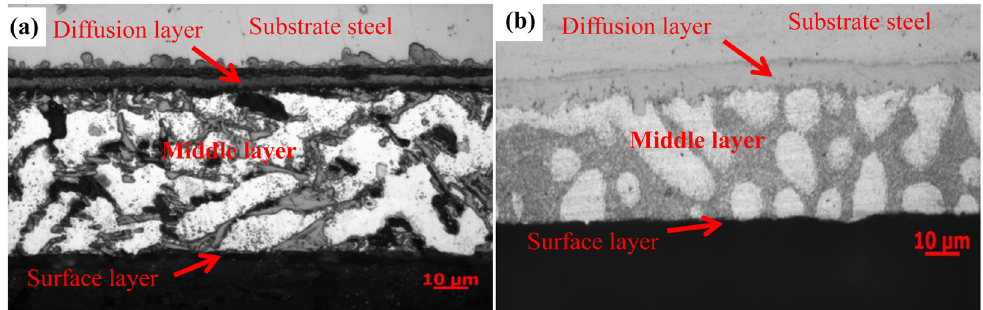
Figure 9: OM microstructure of coatings: ( a ) Al – Si – Cu coating and ( b ) Al – Si coating.